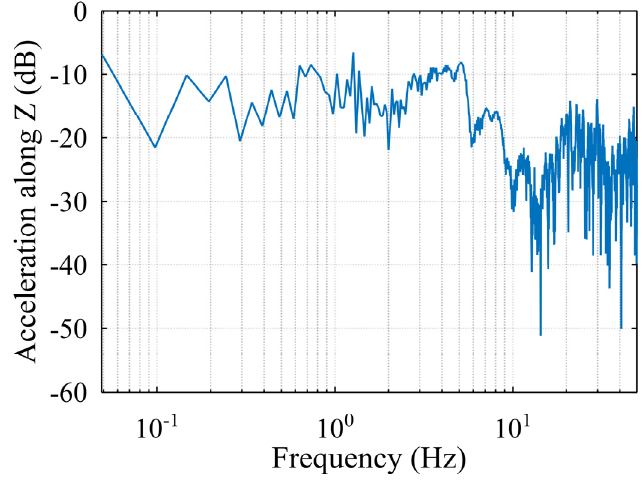
Figure 11. Acceleration spectrum along the Z-axis.